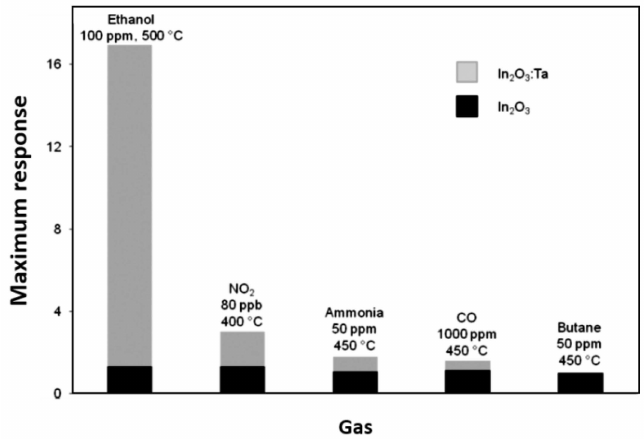
Figure 11. Maximum gas response of doped and undoped In 2 O 3 against different gases at optimum operating temperature. Reprinted from [95] with permission from American Chemical